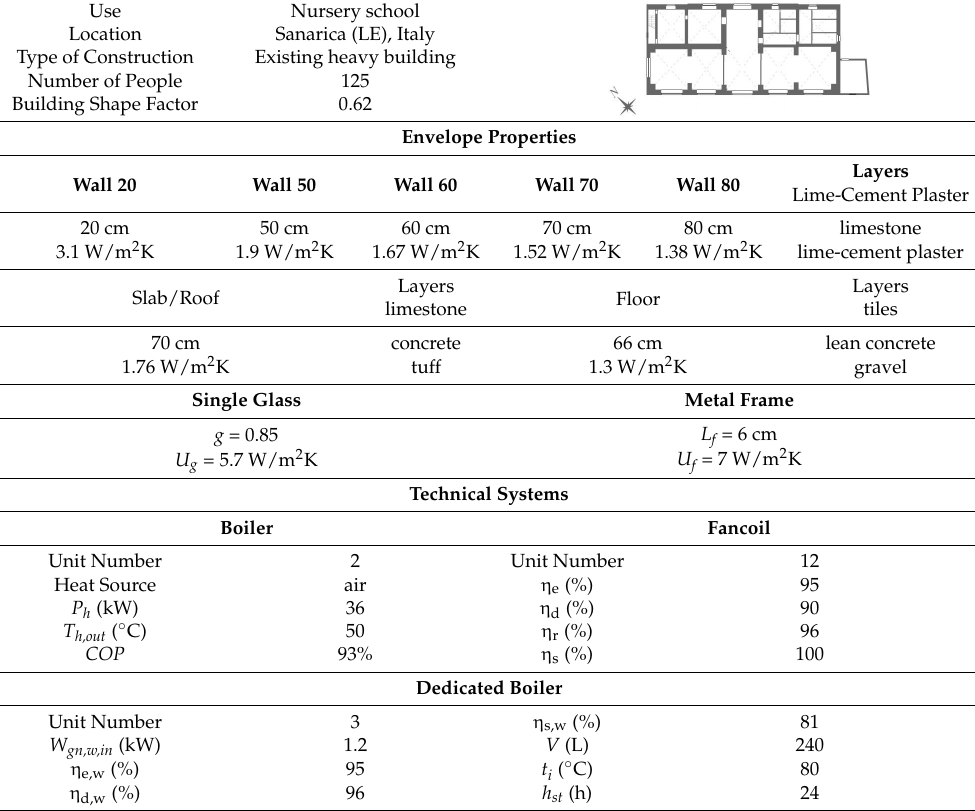
Table 2. Construction properties and element data set of reference building 1 (REF1).